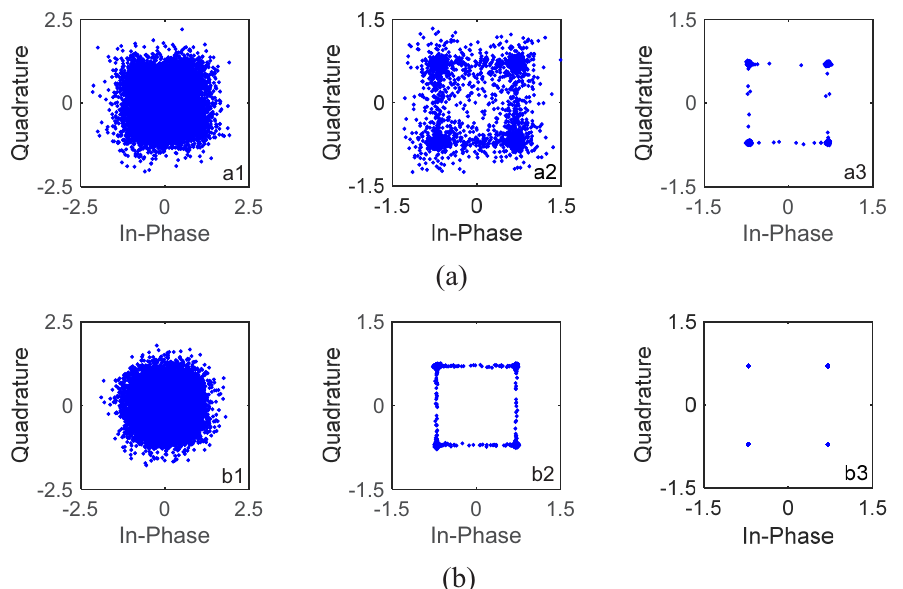
Figure 21. Constellations of the 16 blocks of data with S256 after 0, 1 and 2 iterations for Yellow Sea 2 in Table 5. ( a1 ) Rate-1/2, 0 iteration; ( a2 ) rate-1/2, 1 iteration; ( a3 ) rate-1/2, 2 iterations; ( b1 ) rate-1/4, 0 iteration; ( b2 ) rate-1/4, 1 iteration; ( b3 ) rate-1/4, 2 iterations.